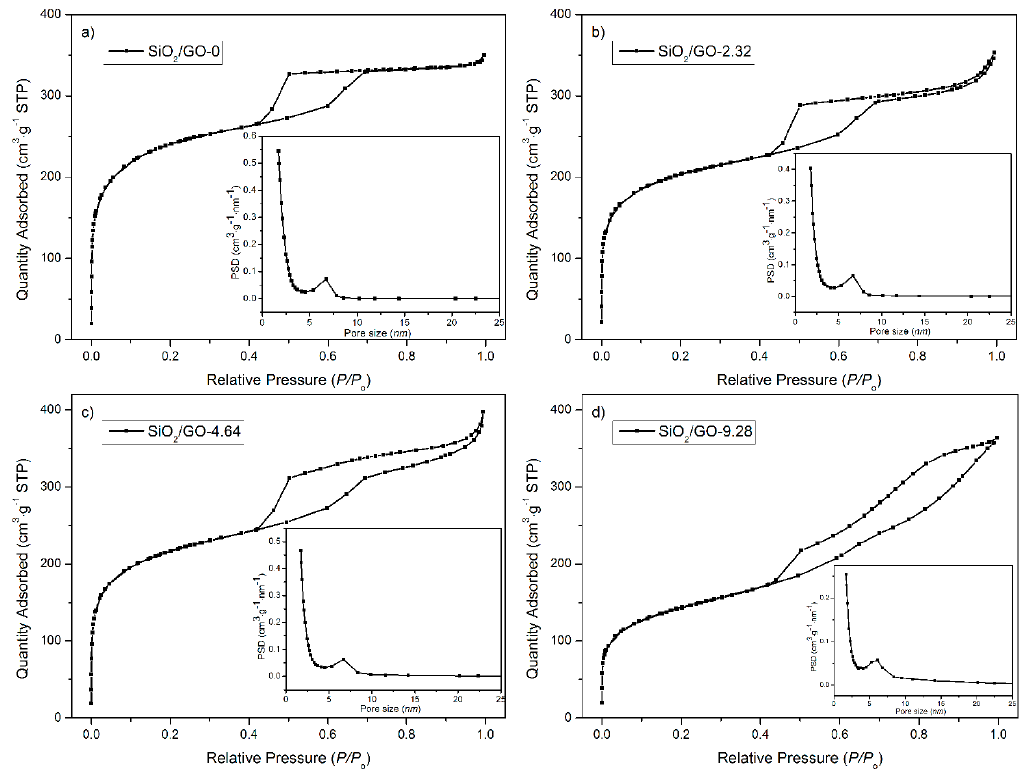
Figure 2. Nitrogen ad/desorption isotherms of the synthesized silicas SiO 2 /GO- x : ( a ) x = 0; ( b ) x = 2.32; ( c ) x = 4.64; ( d ) x = 9.28 .